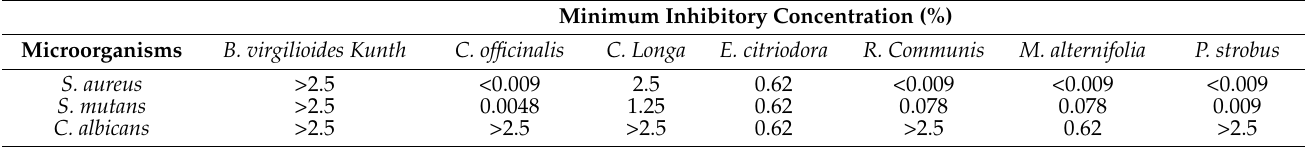
Table 6. Minimum Inhibitory Concentration (MIC) of oils against S. aureus , S. mutans and C. albicans .